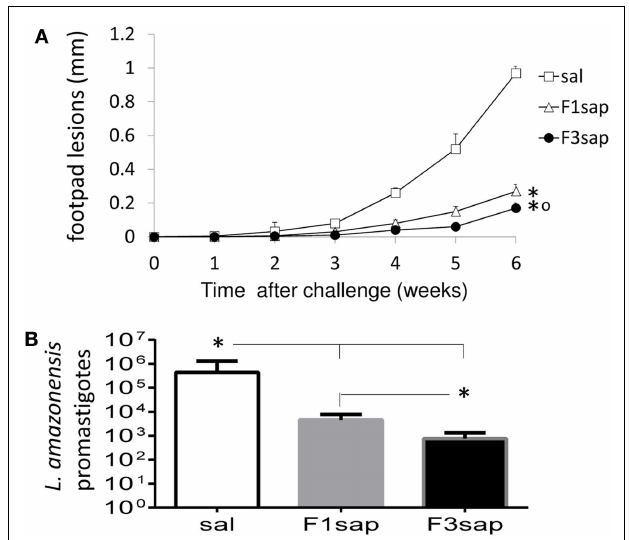
FIGURE 5 | Long-term cross-protection generated by the F3sap and F1sap vaccines. Balb/c mice were vaccinated with three doses of F1sap or F3sap with a weekly interval and challenged with L. amazonensis infective promastigotes, 30days after the last immunization.The evolution of the sizes of footpad lesions (A) and the parasite load in lesions (limiting dilution assay) (B) were determined. Bars represent the mean ± SD of one experiment with 10 mice for each treatment. * p < 0.05 significant differences from the saline controls and ◦ from the F1sap vaccine.